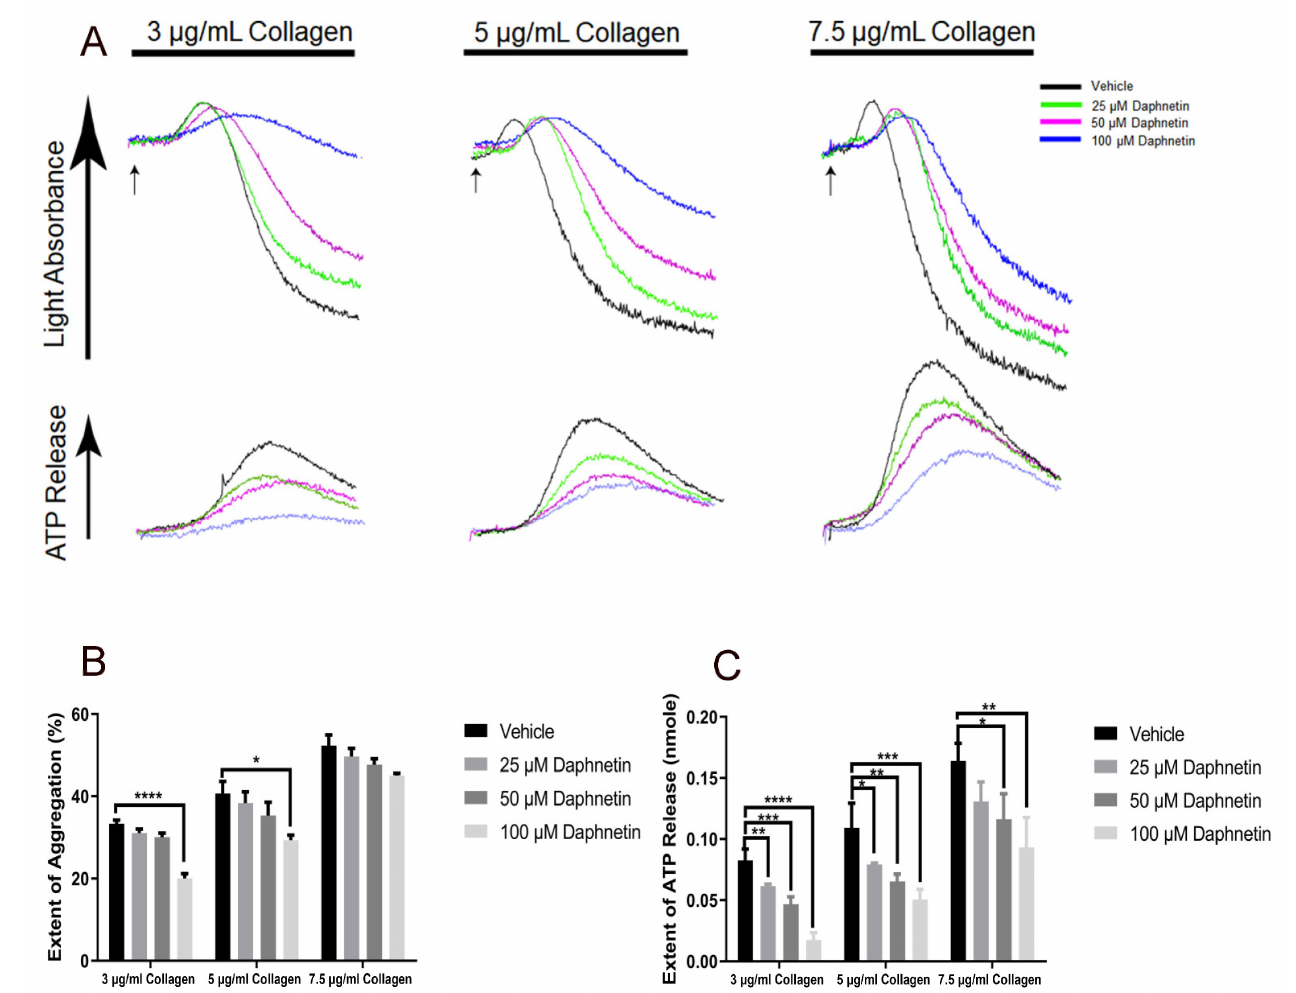
Figure 1. The effect of daphnetin on collagen-induced platelet aggregation and secretion. ( A ) Washed murine platelets were stimulated with GPVI agonist 3 µ g/mL, 5 µ g/mL, and 7.5 µ g/mL collagen in the presence of different concentrations of daphnetin for 3.5 min. Platelet aggregation (top) and ATP secretion (bottom) were analyzed in a Lumi-aggregometer. Data are representative of three independent experiments ( n = 3). Quantification of the ( B ) extent of aggregation and ( C ) dense granule secretion from panel A. Data are presented as mean ± SE *, p < 0.05; **, p < 0.01; ***, p < 0.005; ****, p <